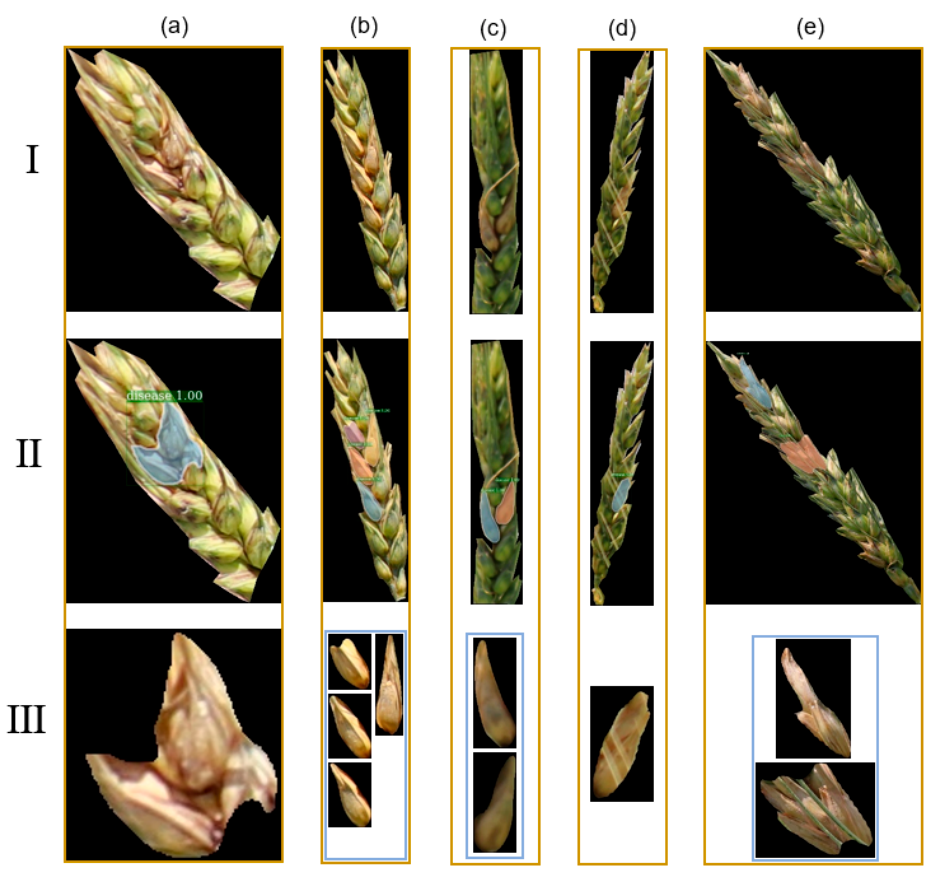
Figure 8. Illustration of ( Ⅱ ) disease area detection and ( Ⅲ ) segmentation results from ( Ⅰ ) the indi- vidual wheat spikes in test set; ( a ) diseased areas with shadow; ( b ) diseased areas under strong light; ( c ) diseased areas under low light; ( d , e ) diseased areas under awn occlusion.